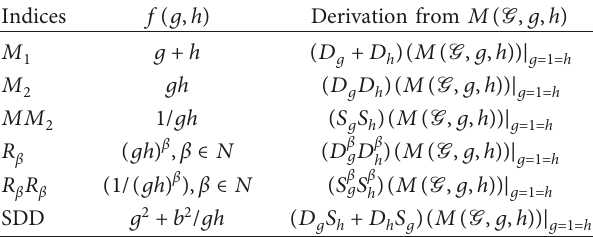
Table 1: Derivation of TIs from M-polynomial. Indices f ( g, h ) Derivation from M ( G ,g,h )